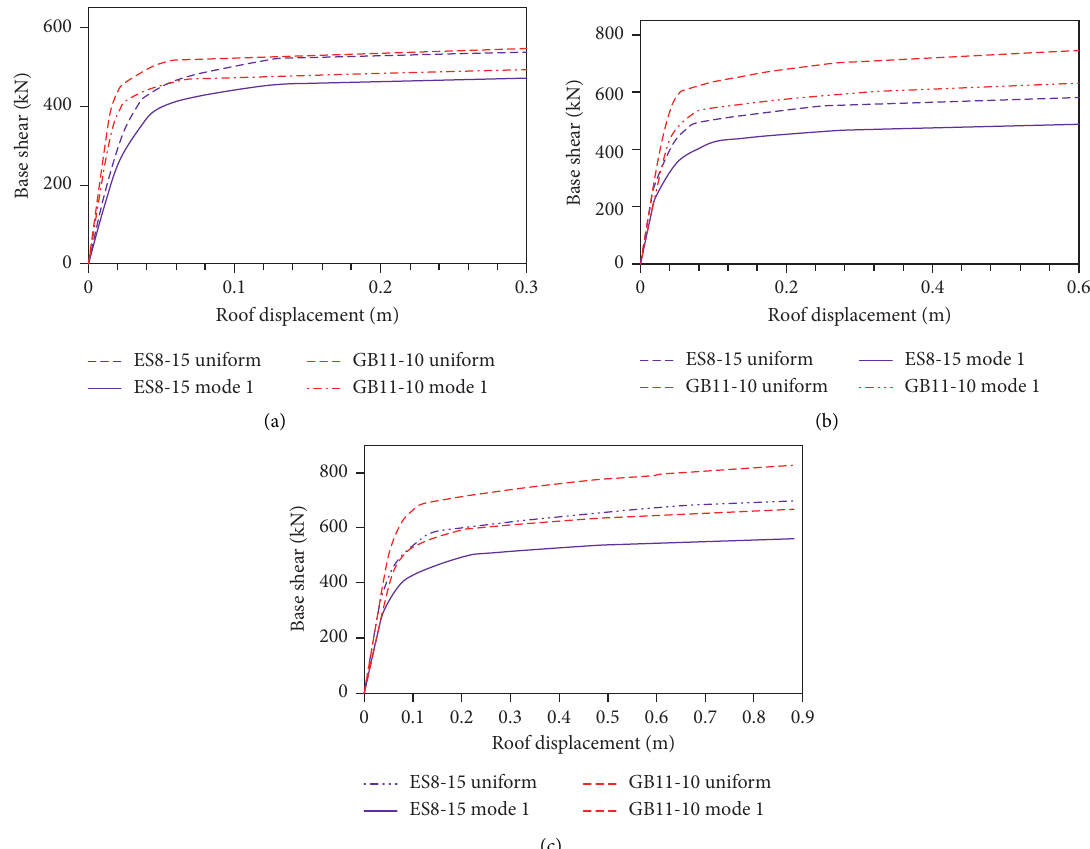
Figure 10: Pushover curves: (a) 4-story, (b) 8-story, and (c) 12-story frames.